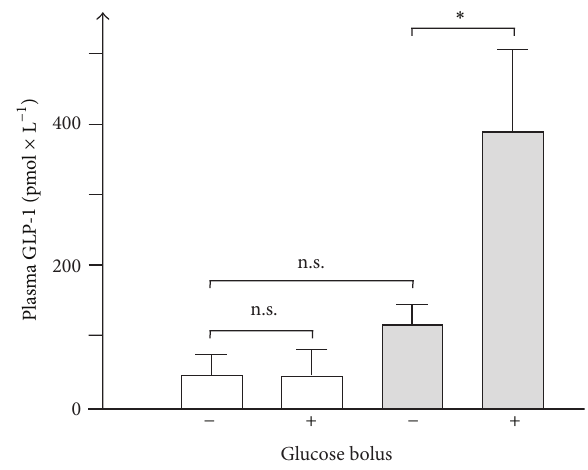
Figure 5: Effect of IIP on GLP-1 secretion after glucose gavage. In rats on HFD with STZ-induced diabetes either sham operation (white columns) or IIP surgery (grey columns) was performed during their 13th week of life. Four weeks later, the mice were force- fed with PBS (glucose bolus − ) or with PBS containing glucose (glucose bolus +). Fifteen minutes later, total GLP-1 was measured in venous blood plasma obtained from the tail. Mean values ± SEM from six animals are presented. ∗ 𝑝 < 0.05 .